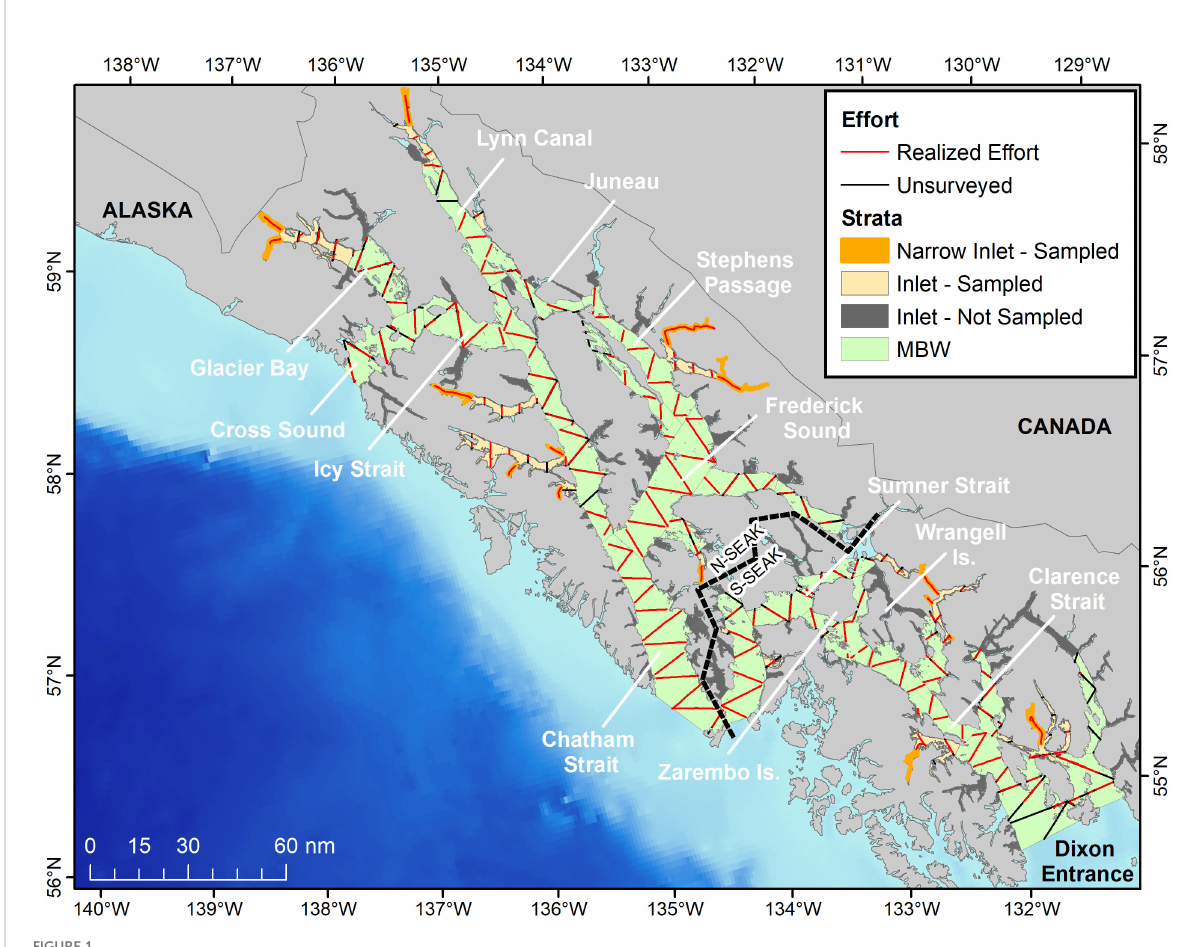
The survey area was divided into two main strata of varying geometry (Figure 1): The stratum labeled “ Main Water Bodies ” (hereafter referred to as “ MWB ” ) spanned an area of 18,632 km 2 (78.2% of the study area) and encompassed the main waterways of SEAK, including Cross Sound, Glacier Bay, Icy Strait, Chatham Strait, Frederick Sound, Stephens Passage, Summer Strait and Clarence Strait. The MWB largely coincided with areas sampled by previous harbor porpoise surveys in the region (Hobbs and Waite, 2010; Dahlheim et al., 2015). The stratum labeled “ Inlets ” (hereafter referred to as “ I ” ) corresponded to an area of 5,189 km 2 (21.8% of the study area) and included small fjords, inlets and narrow straits and passages, the majority of which were not consistently surveyed in previous